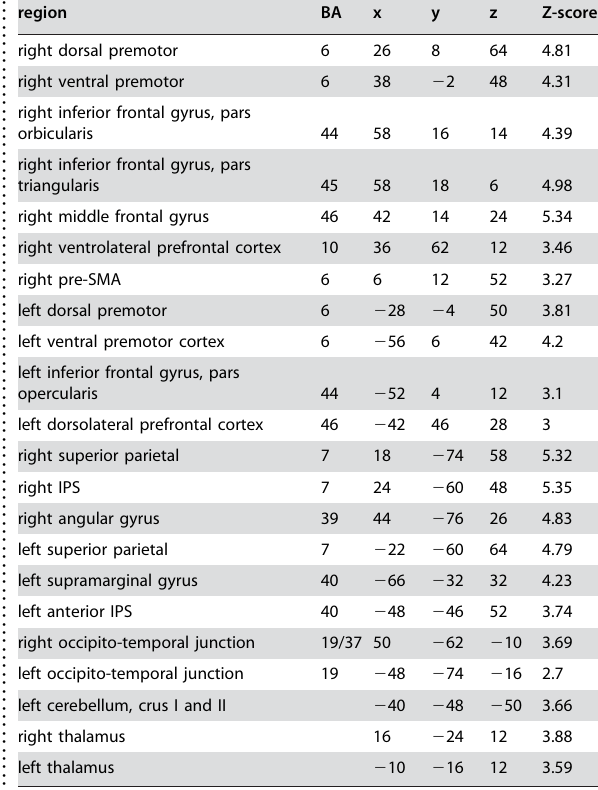
Table 4. Peak voxel coordinates in MNI space and z-values for the fMRI contrasts revealing the regions showing a higher activation for the action observation task than for the